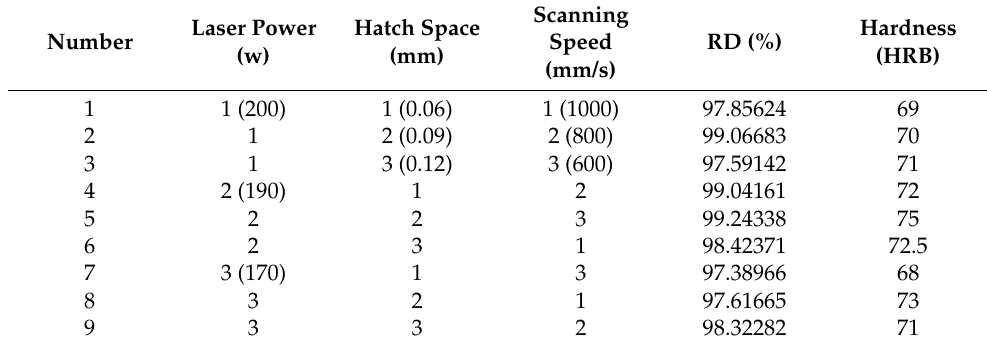
Table 2. The design and results of orthogonal experimental.